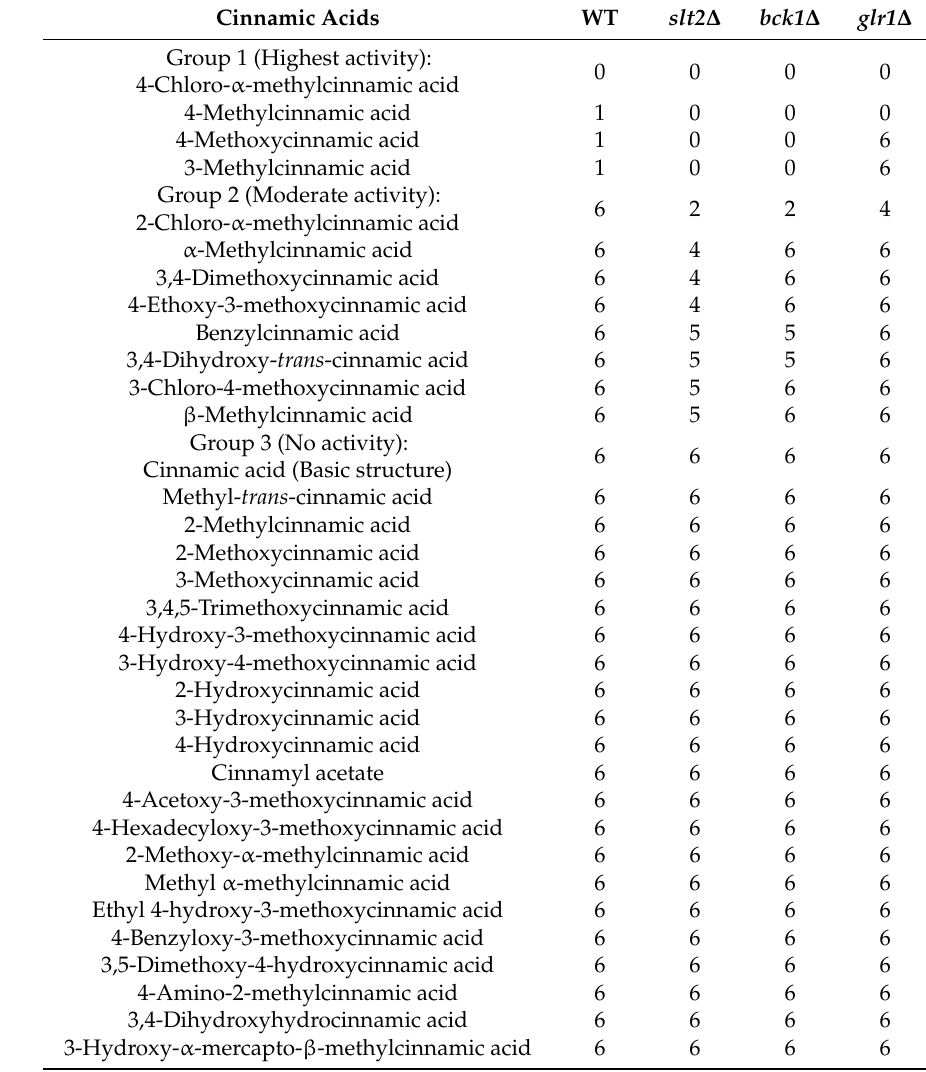
Table 1. Growth scores of yeast strains at 0.5 mM (cutoff) of cinnamic acid analogs during yeast dilution bioassay (WT, Wild type; 0, No growth; 6, Full growth; See Experimental section). Cinnamic Acids